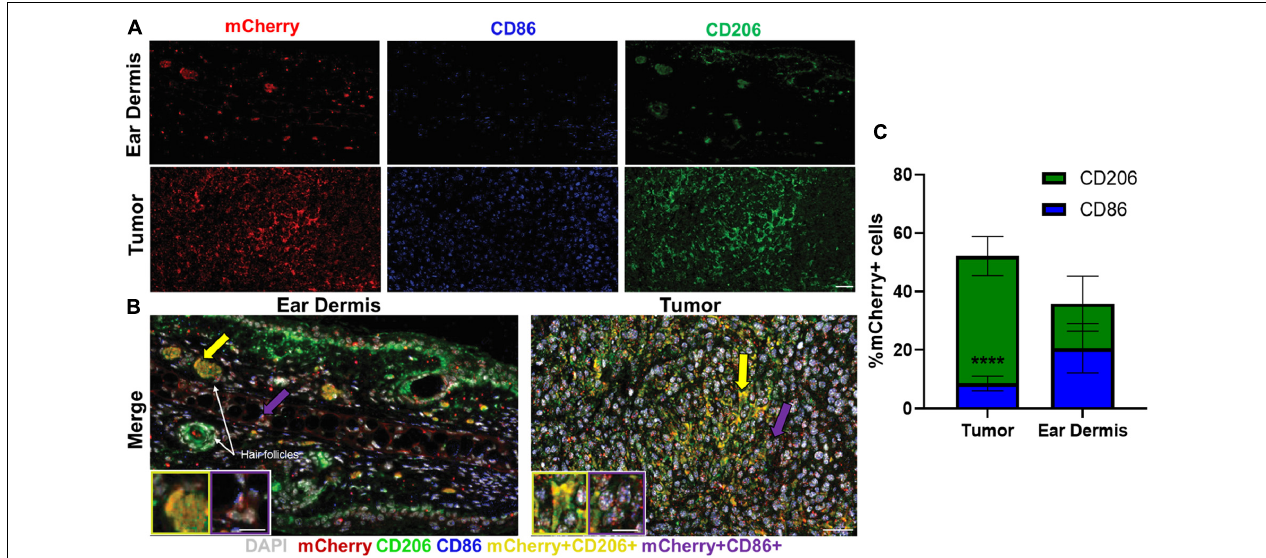
FIGURE 4 | Immunofluorescence staining reflects heterogeneity in macrophage phenotypes across tissue types. Representative immunofluorescence images of resident macrophages in mouse ear dermis and infiltrating macrophages within mouse Panc02 pancreatic tumors. (A) Images of individual mCherry (red), CD86 (blue), and CD206 (green) channels visualize distribution of macrophage-specific markers in ear dermis (top) and tumor (bottom). (B) Merged images identify multiple macrophage phenotypes within both tissues. Inlays represent magnifications of cell areas indicated by yellow (left inlay) and purple (right inlay) arrows in original merged images. DAPI – nuclei, gray; CD86/mCherry co-localization – M1-like macrophage, purple; CD206/mCherry co-localization – M2-like macrophage, yellow. Purple arrows point to M1-like staining; yellow arrows point to M2-like staining. Scale bar, inlays = 15 microns, composite image = 50 microns. (C) Quantification of CD206+ mCherry+ macrophage and CD86+ mCherry+ macrophage proportions for both tissue types reveals a greater ratio of CD206+ to CD86+ macrophages infiltrating in tumor tissue than dermal tissue (**** p < 0.0001 CD206+ vs. CD86+), demonstrating greater macrophage heterogeneity in dermal tissue (mean ± SEM; n = 4 mice, 22 ear dermis FOVs, 24 tumor